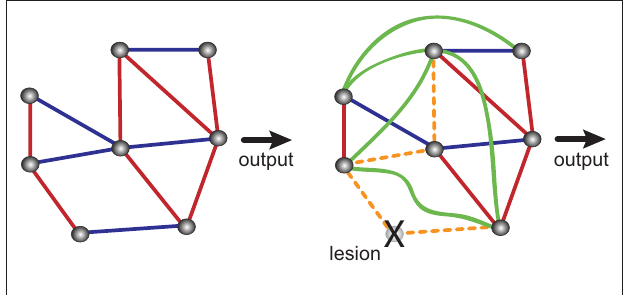
FIGURE 2 | Compensatory changes in an abstract biological network. Blue lines indicate inhibitory interactions, red lines indicate excitatory interactions. Shown are an intact network (left side) and the same network after ablation of one of its nodes. Lesioning one element causes the rest of the system to compensate for the loss. Some interactions are lost (orange dashed lines) and some new interactions emerge (green lines), so that the fi nal output is unchanged. Adapted from Greenspan